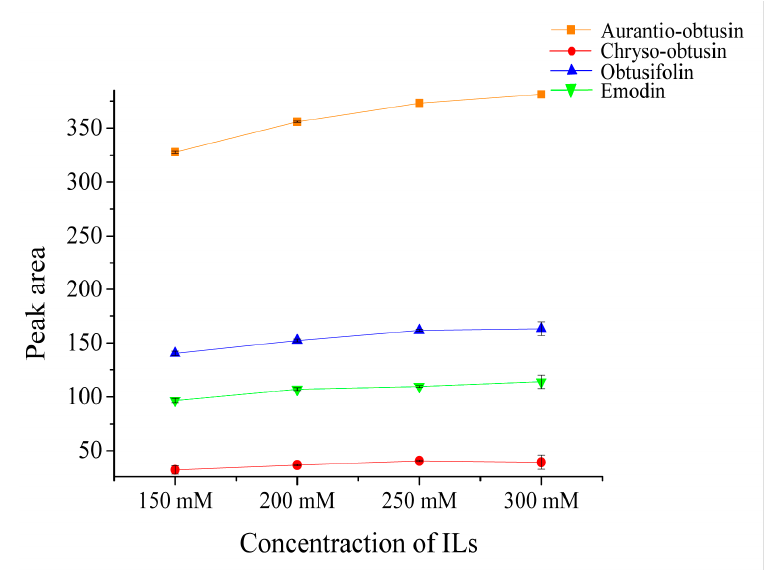
Figure 5. Effect of concentration ILs in VS-MSPD process.